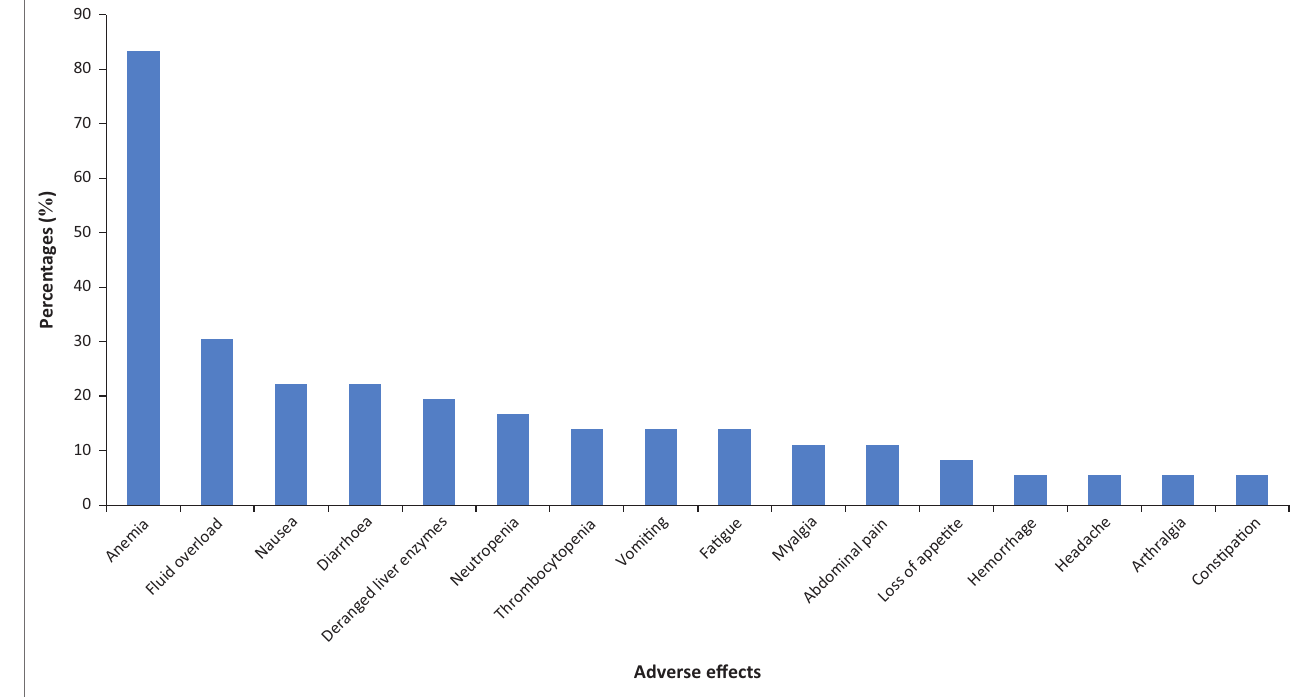
FIGURE 4: Adverse effects occurring in more than 5 % of patients on